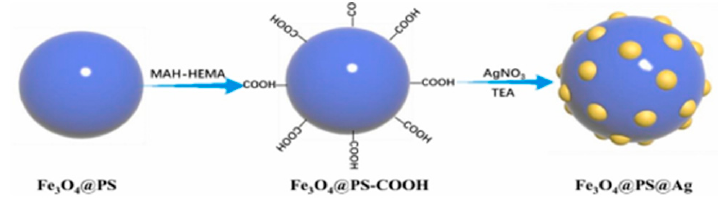
Figure 7. Synthesis of magnetic Fe 3 O 4 @PS@Ag catalyst [66].